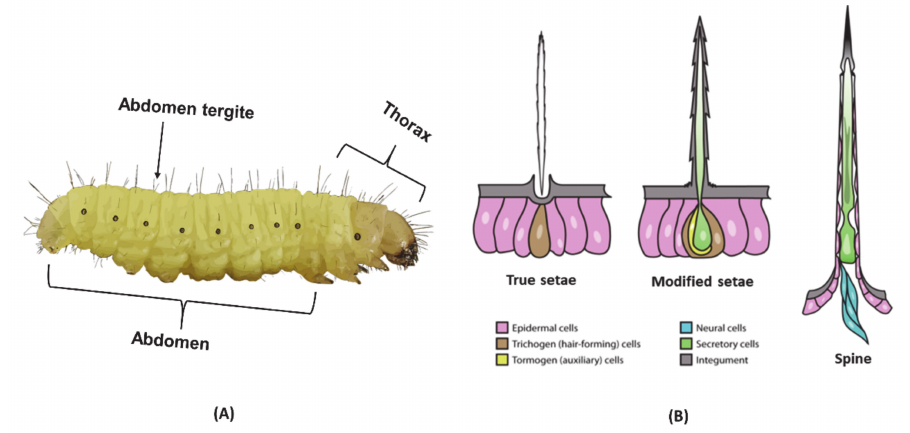
Figure 2. ( A ) Caterpillar morphology. ( B ) Schematic representation of setae / spine copied with permission from